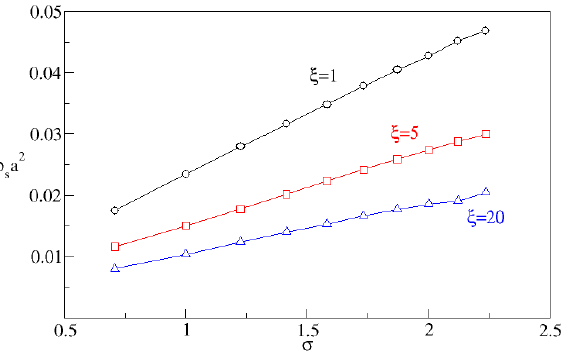
Figure 5. Surface density, ρ s as a function of σ for substrates with correlation length ξ = 1 (circles), ξ = 5 (squares), and ξ = 20